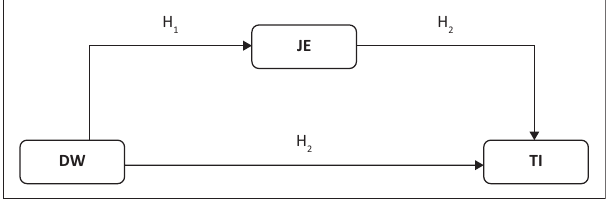
FIGURE 1: Proposed structural equation model.